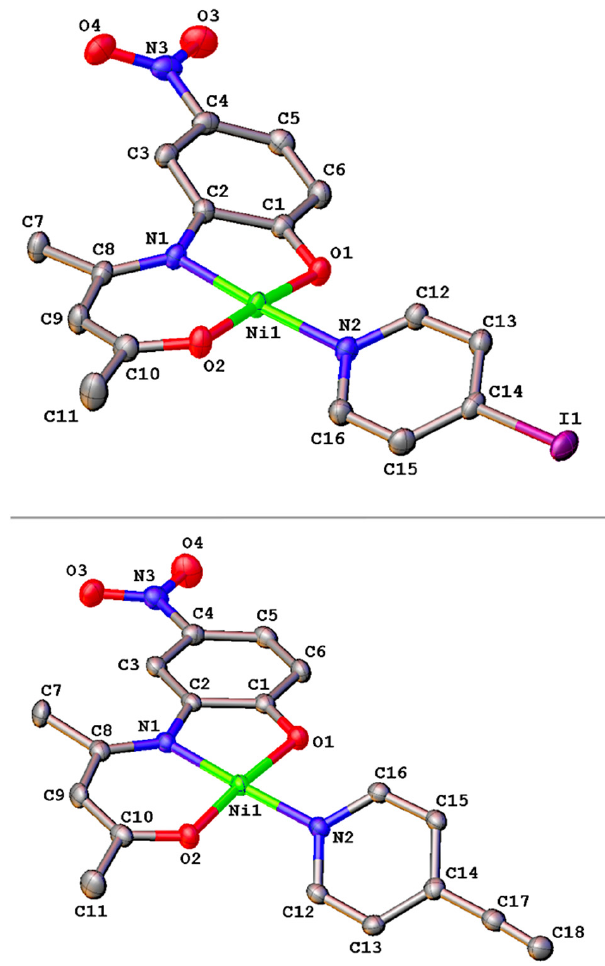
Figure 1. Molecular structures of complexes 4 ( top ) and 5 ( bottom ), with labelling scheme for selected atoms. Hydrogens have been omitted for clarity. Thermal ellipsoids are drawn at the 50% probability level.